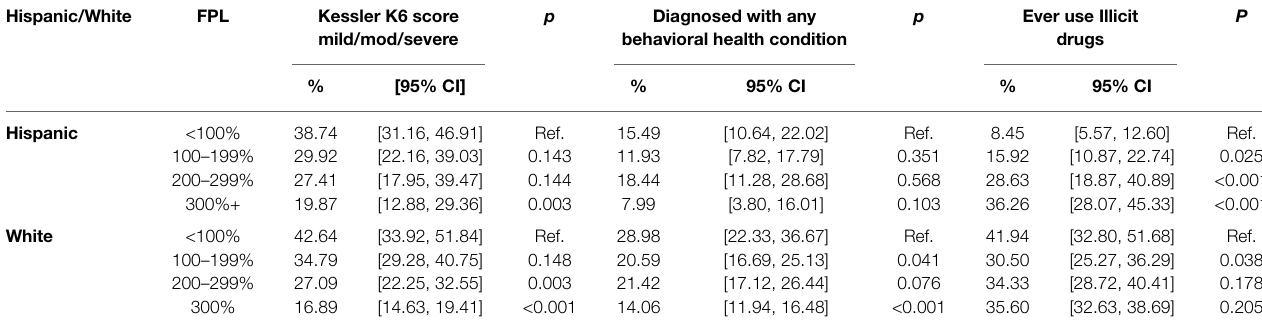
TABLE 2 | Kessler score, mental health diagnosis, and illicit drug use by race/ethnicity and federal poverty limit (FPL) of White and Hispanic respondents of the 2010 Arizona health survey ( n = 6,070) . Hispanic/White